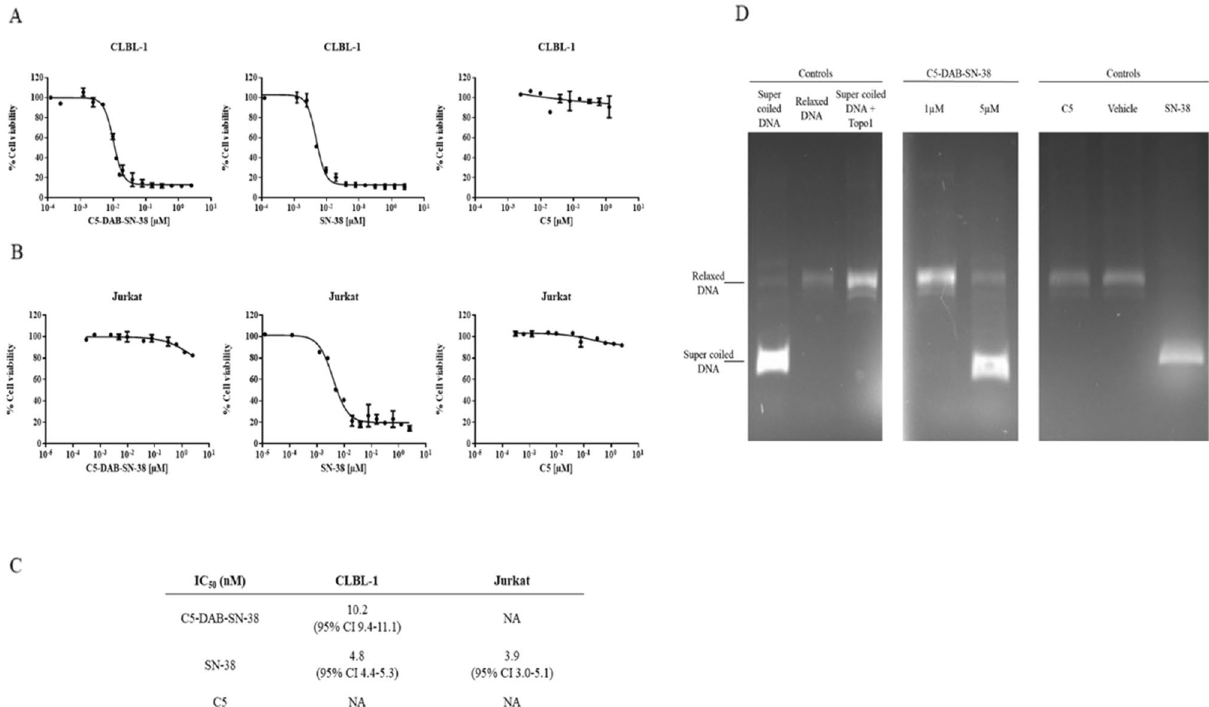
Figure 7. Cytotoxic effects of C5-DAB-SN-38. To determine the effect of C5-DAB-SN-38 on CLBL-1 and Jurkat cells, a cell viability assay was performed using the WST-1 reagent. 6 × 10 4 cells were seeded and treated with increasing amounts (2.5 μM to 12.5 nM) of each compound (C5, C5-DAB-SN-38 and SN-38). After 48 h treatment, cell viability was assessed. ( A ) C5-DAB-SN-38 demonstrated a dose-dependent cytotoxicity effect on cNHL cells. ( B ) On the other hand, C5-DAB-SN-38 had no effect on Jurkat cells, proving the specificity of the ADC. C5 was used as control. ( C ) Best-fit EC50 values of each formulation were calculated using GraphPad Prism software (version 9.2.0, San Diego, CA, USA) using the log (inhibitor) vs response (variable slope) function. D ) Effects of C5-DAB-SN-38 on DNA TopoI activity. To evaluate the effects of C5-DAB-SN-38 on DNA Topo I, we evaluated its activity using the Human Topoisomerase I Assay Kit. After incubation of C5-DAB-SN-38 with 1 × reaction buffer and 10 U of Topo I for 1 h at 37 °C, the supercoiled DNA was added. To stop the reaction, stop loading buffer was added. DNA TopoI activity was visualized by 1% agarose gel electrophoresis attained with ethidium bromide. Relaxed DNA indicated TopoI activity, while supercoiled DNA indicated an inhibition. The presence of C5-DAB-SN-38 at higher concentrations inhibits DNA TopoI in a dose dependent manner, empathizing the effect of SN-38, present on the ADC, as a cause of cell death. Relaxed DNA and supercoiled DNA were used as positive/negative controls. C5 and SN-38 were also used as controls. Image is part of the original gel that is presented in Supplementary Fig. specificity of the interaction between the sdAb and cNHL cells and the subsequent complex internalization, which are key attributes for the success of an ADC. Importantly, the biodistribution studies demonstrated that C5 exhibited a good tumor uptake with an accumulation percentage of around 1.5% ID/g after 15 min of injec- tion, meaning that an adequate amount of our sdAb is reaching the tumor. The biodistribution profiles of different antibody formats were already compared by different groups. Schneider et al. 48 , compared different antibody formats, including scFvs, and the percentages of tumor uptake obtained were between 1 and 1.5% for 25 min and 3 h after injection. Another study conducted by Duray et al. 49 using sdAbs, revealed a tumor uptake of 2.22% and 0.79% for 48 h post-injection. The values obtained for small fragments are in the same range as those we obtained for our sdAb, C5, leading us to conclude that our data resulted in a good tumor uptake. Moreover, C5 biodistribution profile presents a rapid clearance from the major organs, except for the organs related with the excretory paths (liver and kidney) and in the spleen. This fast clearance from the systemic circulation is mostly advantageous given that it results in shorter effective circulation times, mitigating the possibility of off-target release. Finally, and importantly to proceed with ADC development, the presence of the free Cys80 at the surface